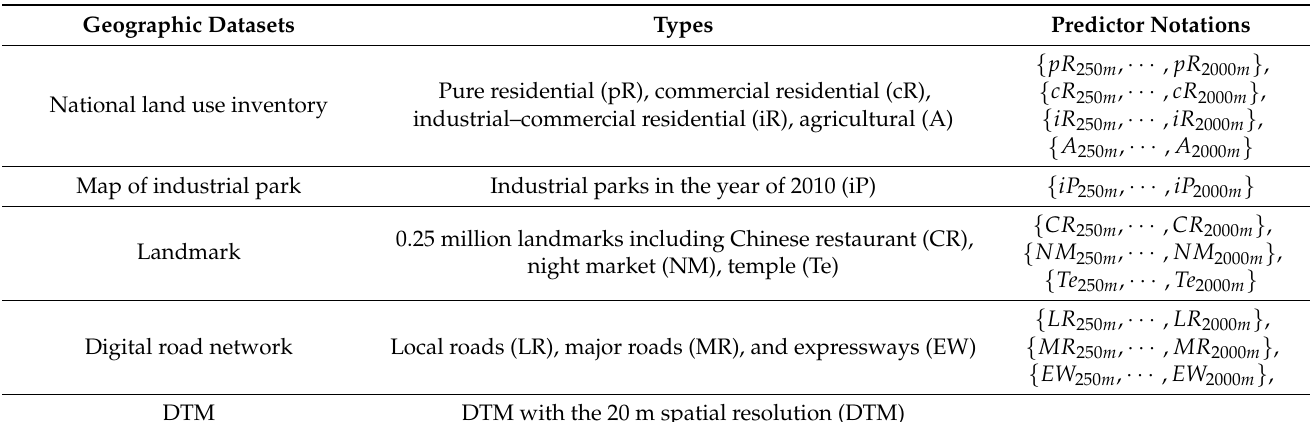
Table 1. Geographic datasets of Taipei Metropolis and related predictors used in PM 2.5